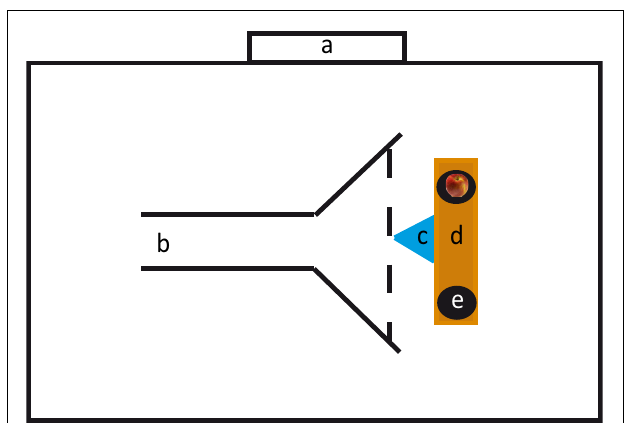
FIGURE 1 | Experimental setup. a: Exit, b: corridor, c: multi-jump block, d: bench, e: bucket.